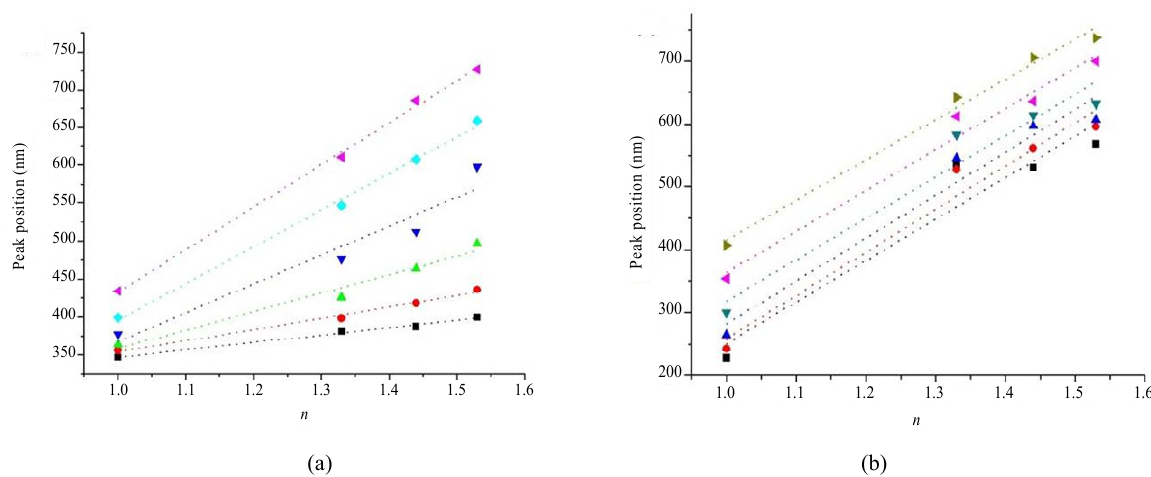
Fig. 8 Relationship between the resonance wavelength and refractive index of the surrounding medium: (a) Ag-Fe and (b) Au-Fe alloys